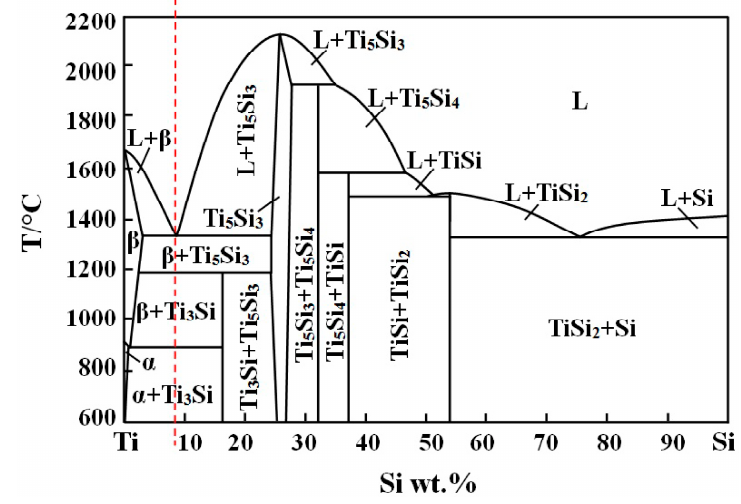
Figure 2. The Ti–Si binary phase diagram.